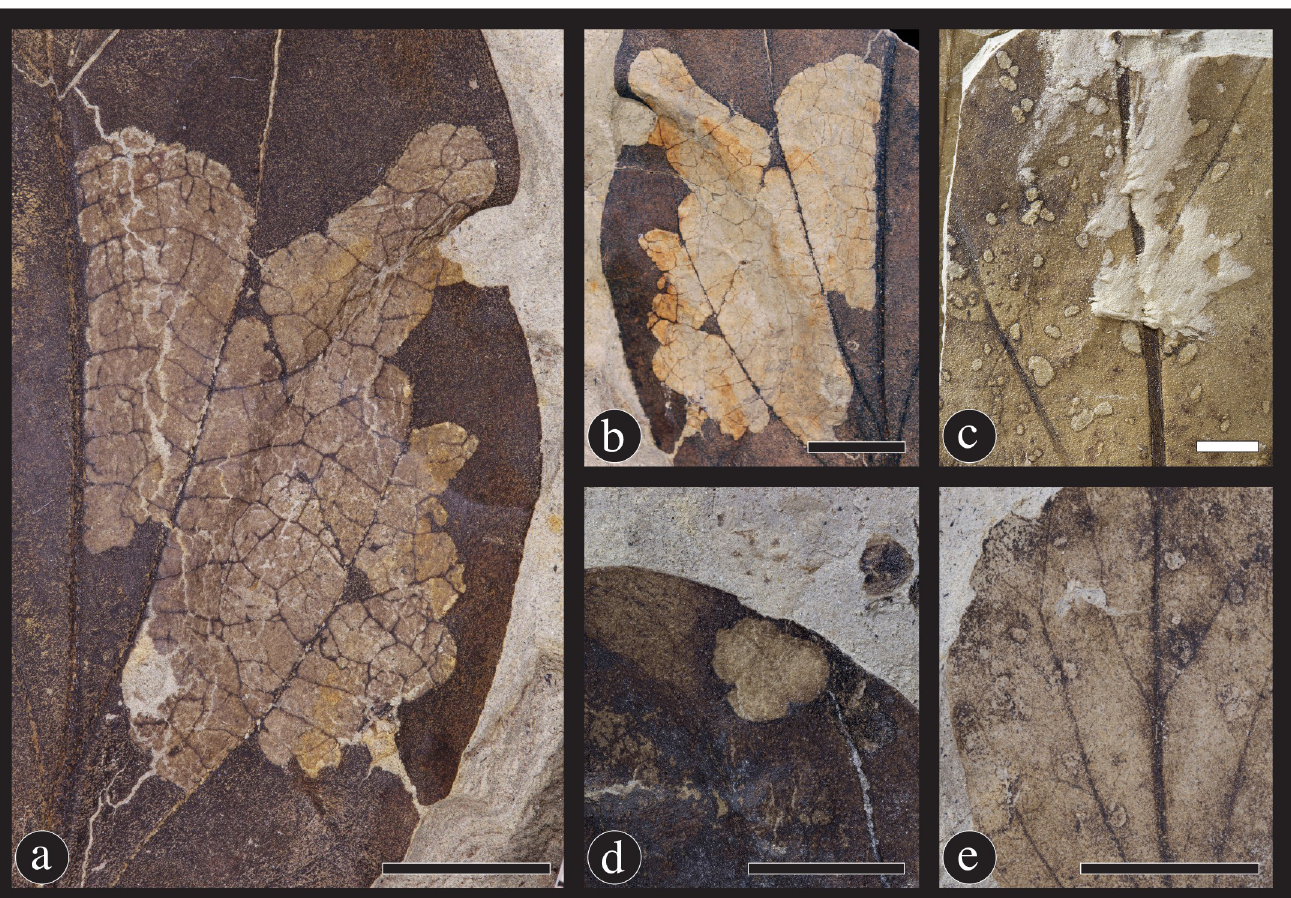
Fig 11. Surface feeding on Catula gettyi at the Lost Valley Locality. These damage types consist of three previously known damage types and one new damage type: (A,B) DT333 (DMNH 39725); This new damage type (DT) entails large areas of herbivory in which one surface of the leaf is removed and third-fourth order venation is left intact. Part A exhibits the rank of undamaged venation and does not have surface tissue removed. Counterpart B illustrates the tissue removal and the presence of intact third and fourth order veins. The other three surface feeding damage types are: (C) DT31; Removal of surface tissue with a distinct circular to ellipsoidal reactions rim (DMNH 41589); (D) DT30; Surface feeding with a polylobate reaction rim (DMNH 41566); and (E) DT29; Surface feeding with a weak reaction rim (DMNH 41593). Black scale bars = 5 mm; white scale bars = 1